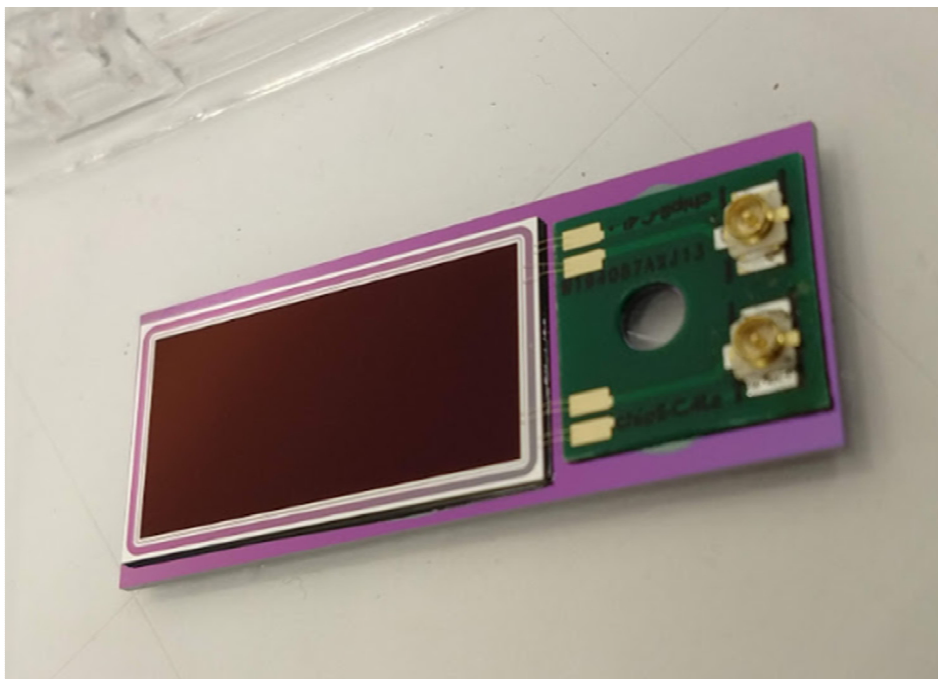
Figure 15. Photodiode packaging: photodiode and PCB mounted on silicon carrier.